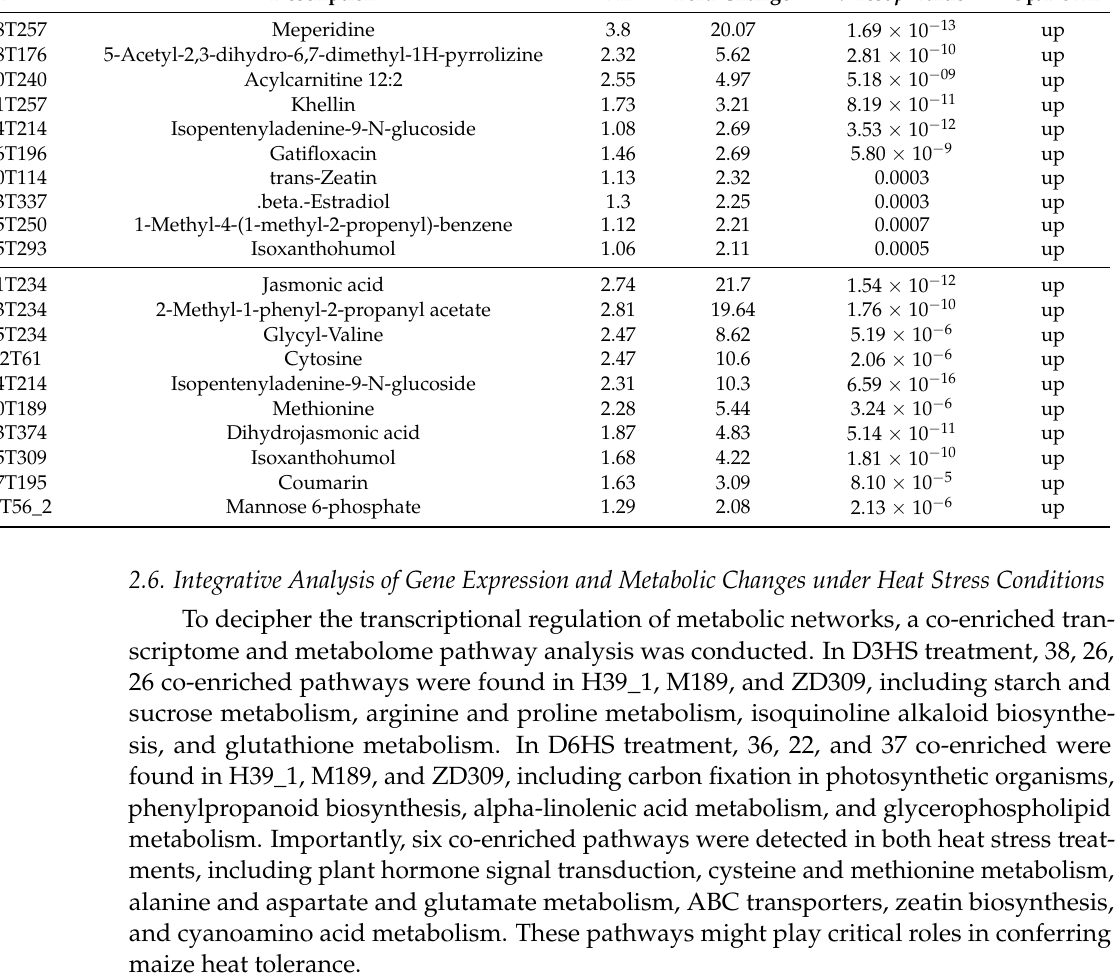
Table 3. Key differentially expressed metabolites in ZD309 and its parental lines in heat treatments.